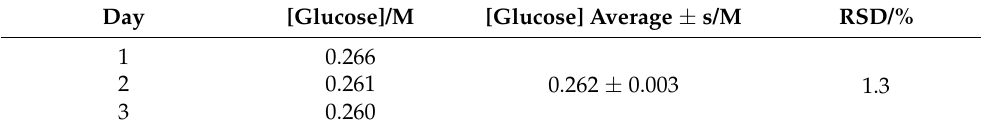
Table 5. Study of the system reproducibility. Measurements were performed on three different days using the same Ti/TiO 2 NTAs/ppHEMA-co-EGDA/pgPFM/GOx/Chitosan